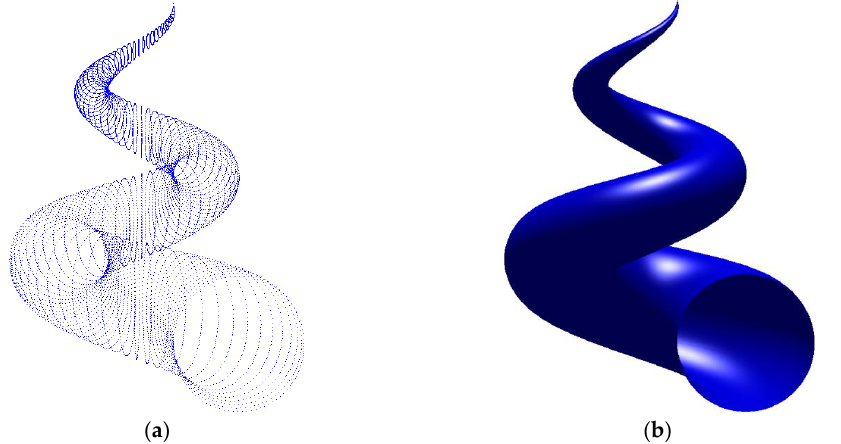
Figure 8. Surface fitting of a shell surface: ( a ) the data chosen randomly from grid data; ( b ) the fitting surface.